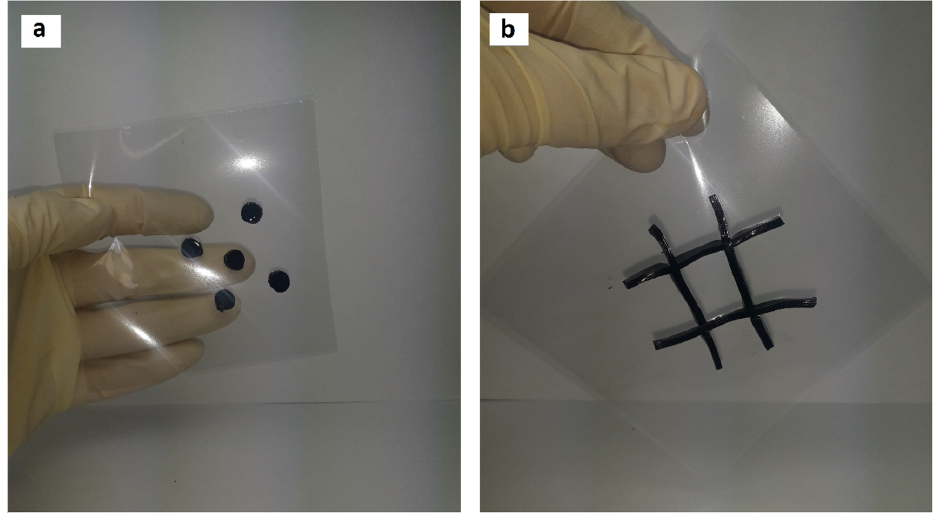
Figure 9. Synthesis of hydrogels of complex geometric shape, intended for the treatment of ( a ) chem ‐ ical burns, ( b ) extensive burns.